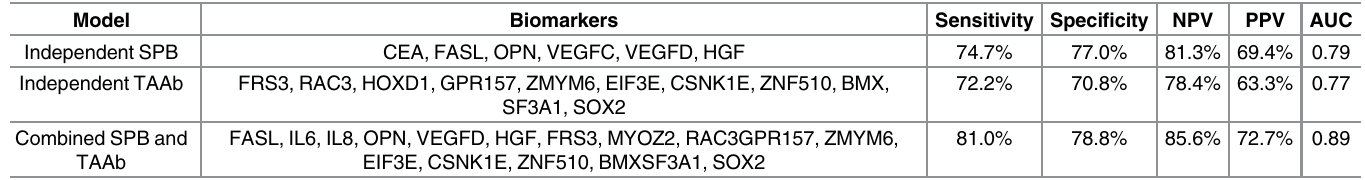
Table 3. Summary of Model Performance. The biomarkers relevant to each model are given, along with model performance parameters. Model